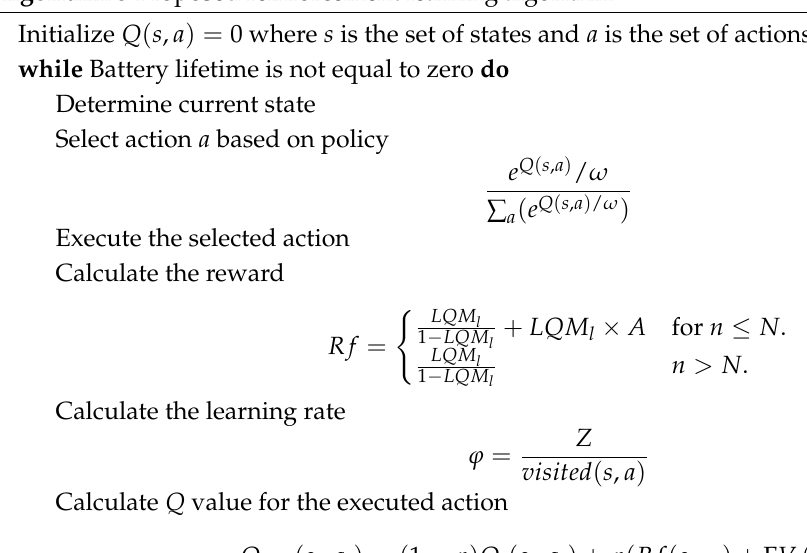
Algorithm 3 Proposed reinforcement learning